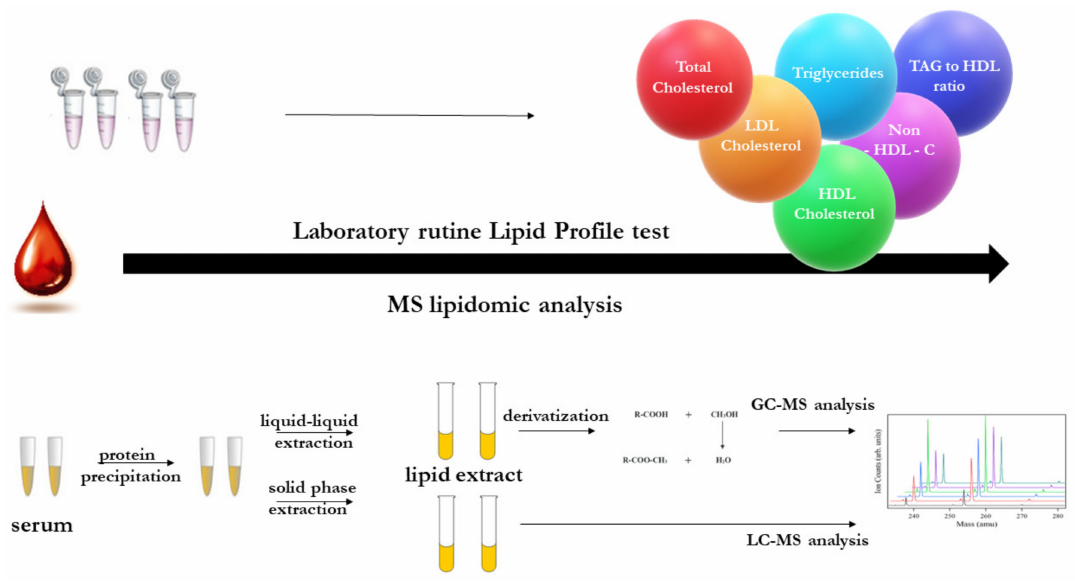
Figure 2. Lipid analysis in diagnostic laboratory vs. advanced lipidomic